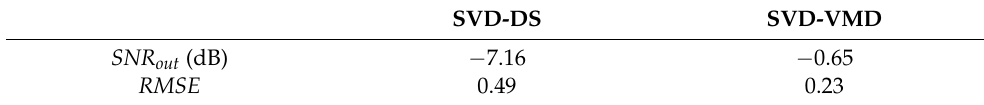
Table 2. Comparison between SVD-DS and SVD-VMD for simulated signals.